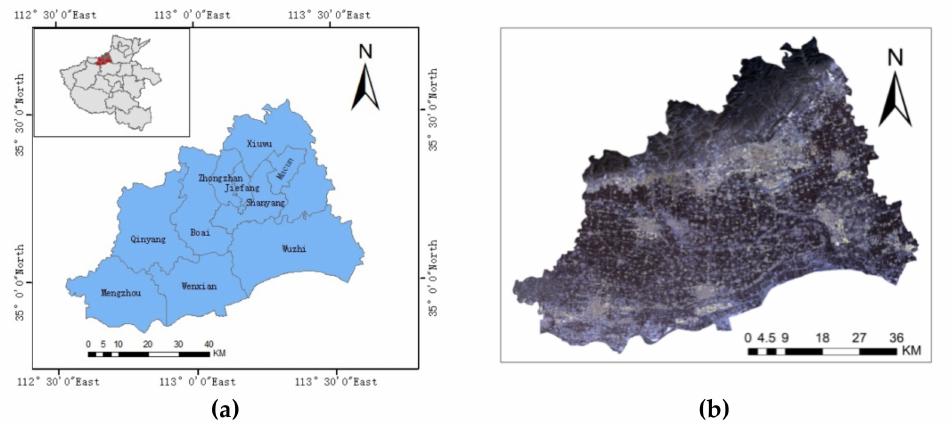
Figure 1. Location and satellite image of the study area: ( a ) Map of Jiaozuo; ( b ) True Color Image of